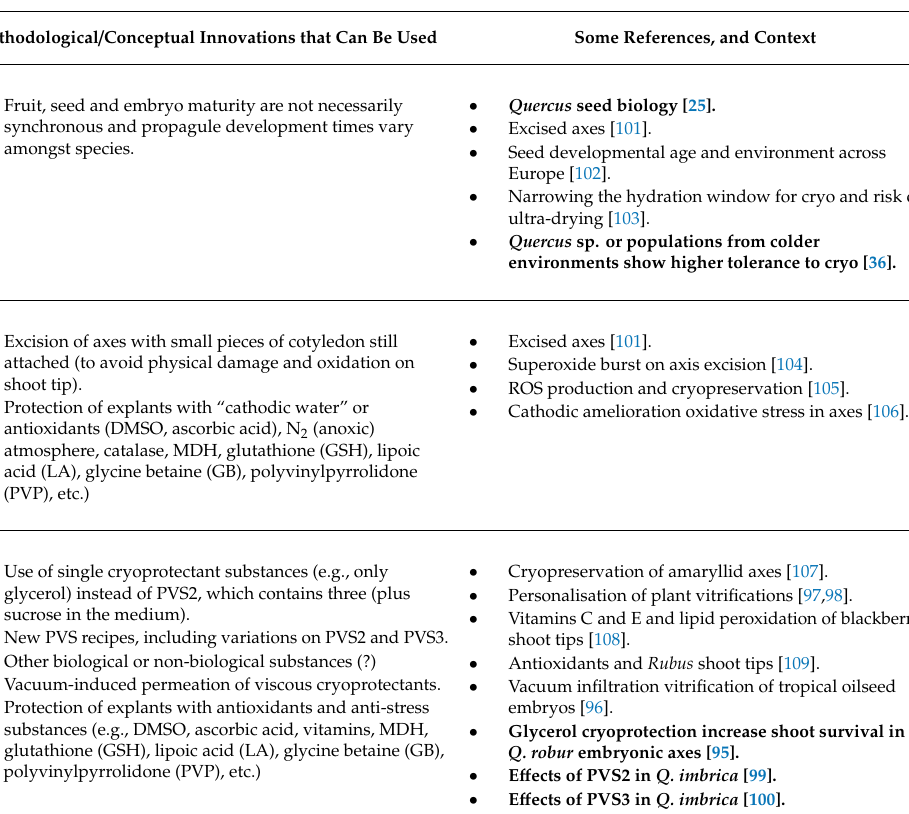
Table 3. Research challenges and innovations in the cryopreservation of embryonic axes and zygotic embryos of recalcitrant seeds. References in bold indicate that the work is related to Quercus